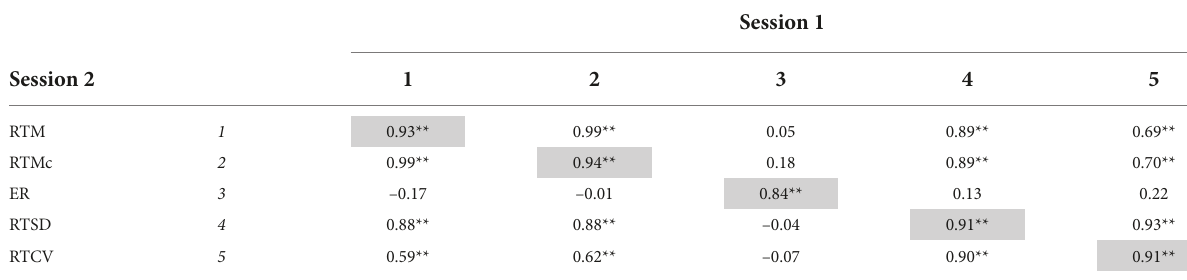
TABLE 3 Multitrait-multimethod-matrix for Experiment 1 and Experiment 2. Experiment 1 (serial mental addition and verification